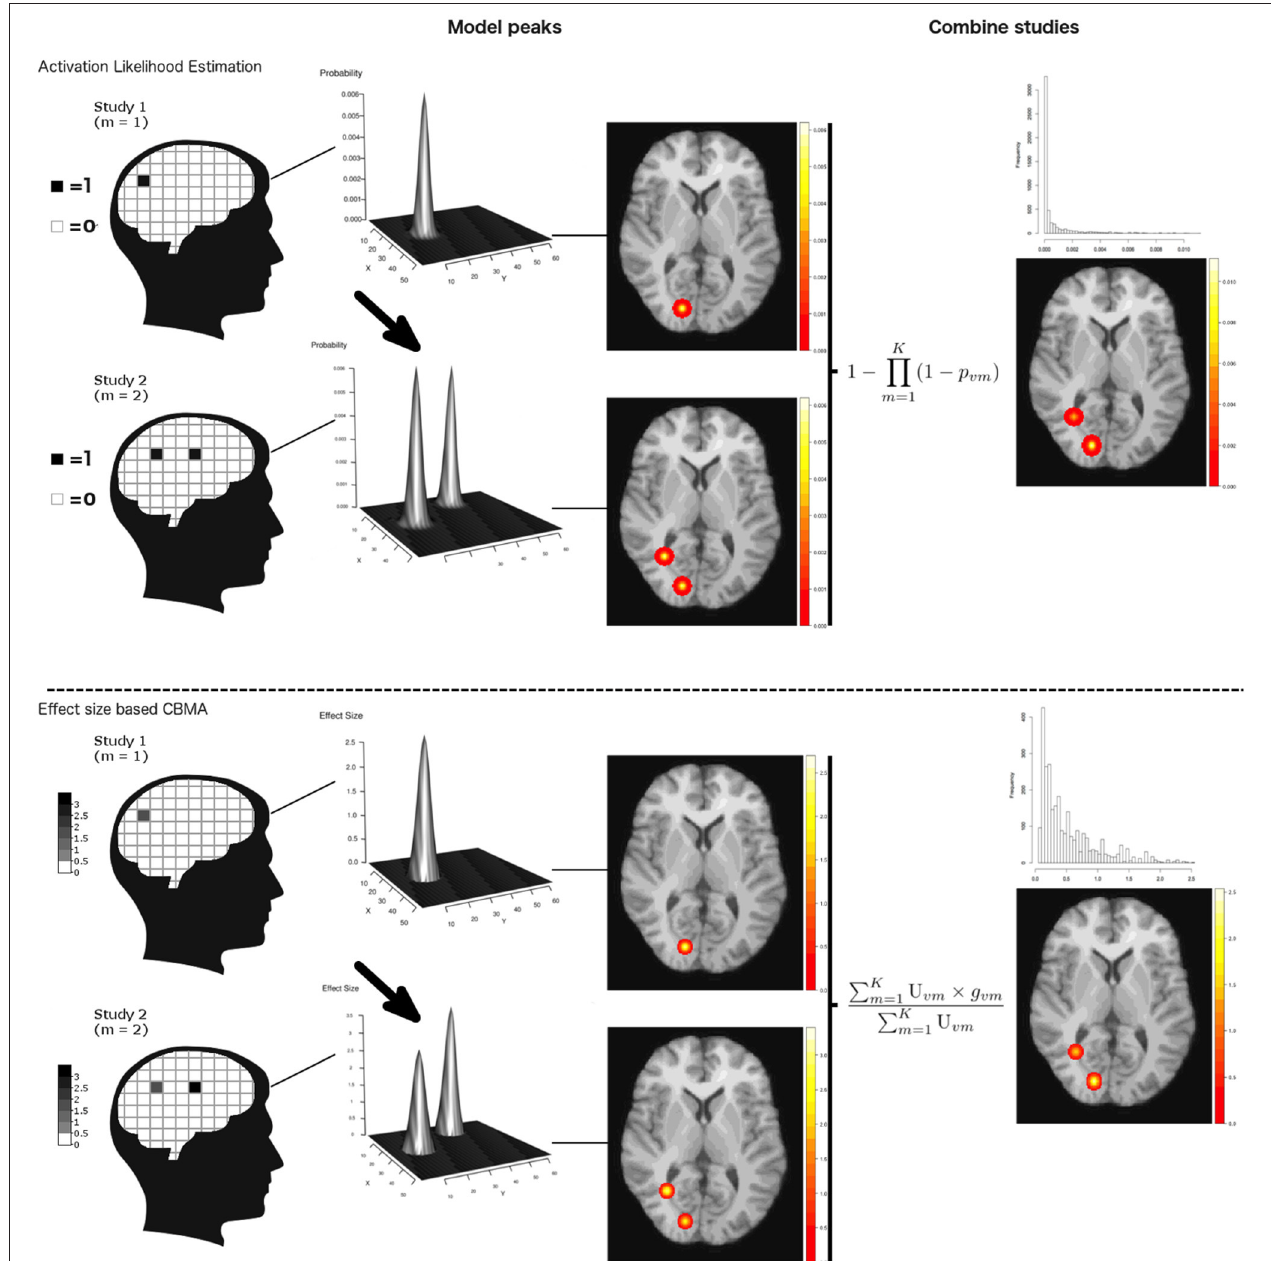
FIGURE 1 | Illustration of ALE and an effect size based CBMA. Reported coordinates are first modeled by applying a Gaussian kernel. These are then combined either through calculating probabilities or by transforming the test-statistics to effect sizes and calculate a weighted average. Note that for illustration purpose, we only plot the values > 0 in the histograms. Illustration is prior to